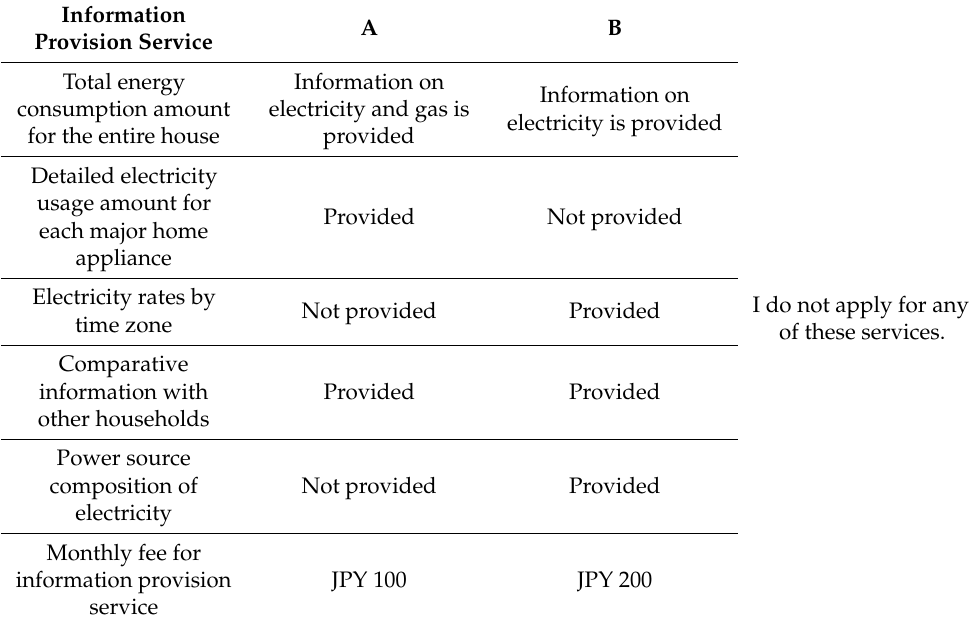
Table 2. An example of a choice